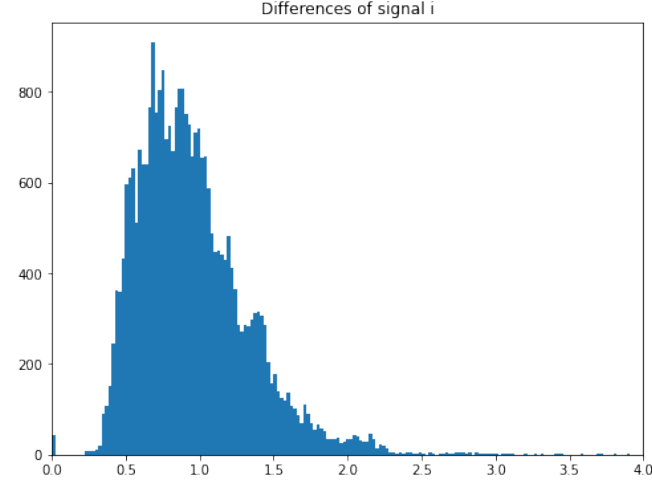
Figure 9. Histogram for the signal ‘i’ in the